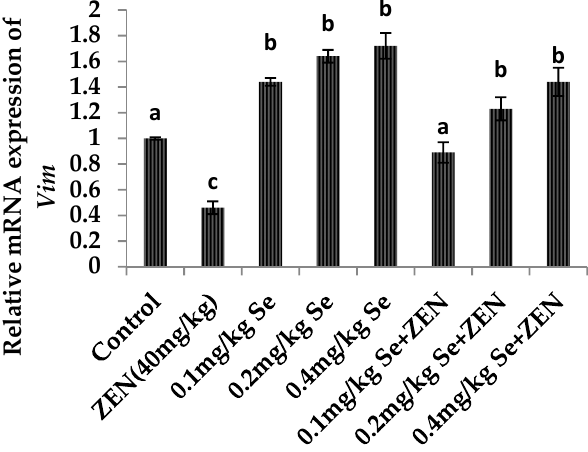
Figure 5. Effect of ZEN, different concentration of Se and their co-treatment on the relative mRNA expression of Vim in mice testicular tissue. Values are mean ± SE of twenty mice in each group. a–c Means with different letters are significantly different, p < 0.05. a p < 0.05 vs. ZEN-treated group, b p < 0.05 vs. control group and ZEN-treated group, c p < 0.05 vs. control group.